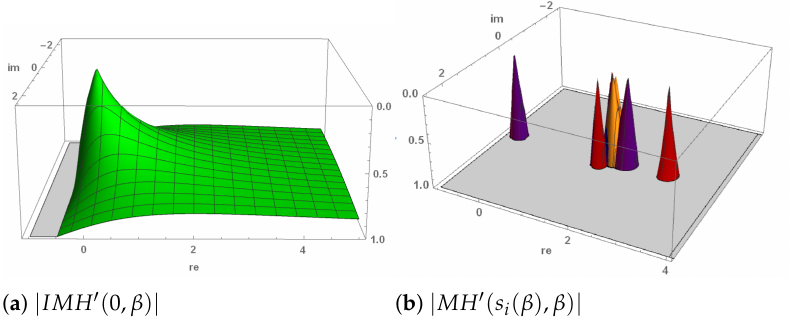
Figure 1. Stability functions of z = ∞ and strange fixed points of MH operator